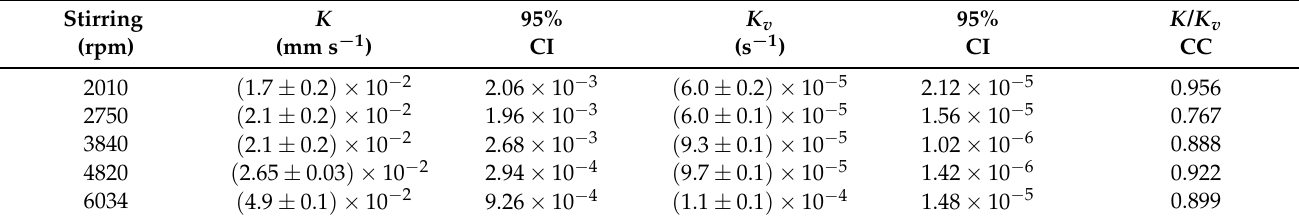
Table A1. K and K v values at different stirring rates (CI, confidence interval; CC, correlation